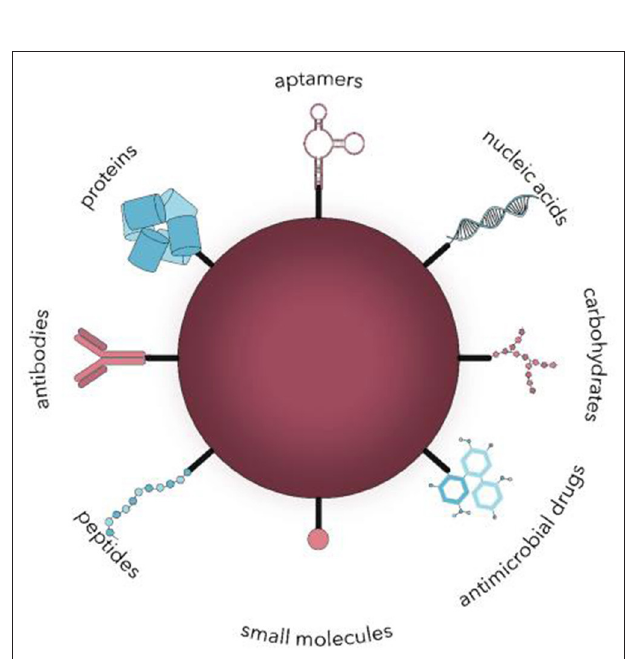
FIGURE 4 | Surface functionalization of nanocarriers with different ligands for active microbial targeting (Spirescu et al.,